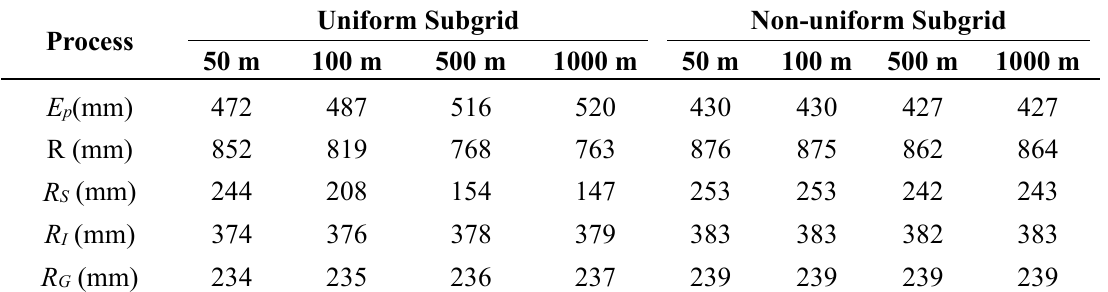
Table 3. Performance of the Grid-Xinanjiang model with and without the subgrid parameterization. Uniform Subgrid Non-uniform Subgrid Process